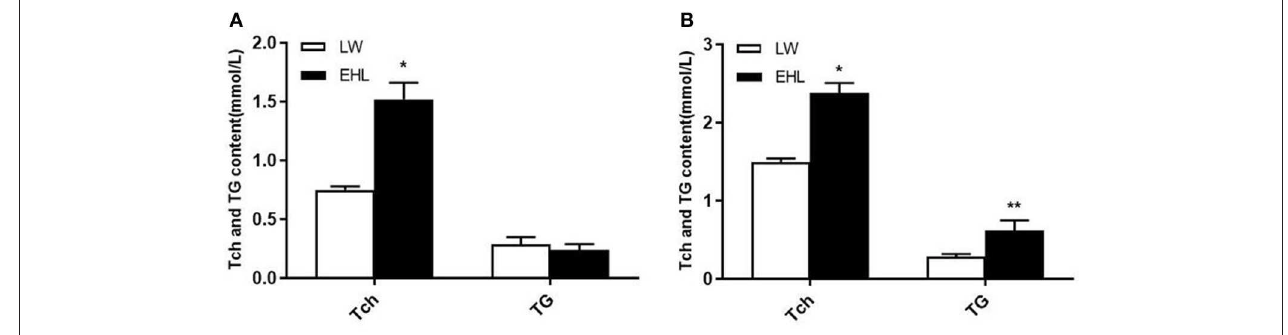
FIGURE 1 | Total cholesterol and triglyceride content of the offspring piglets at birth (A) and weaning (B) ( n = 6 piglets each time point per breed). * P < 0.05 and ** P < 0.01. Data are presented as mean ±